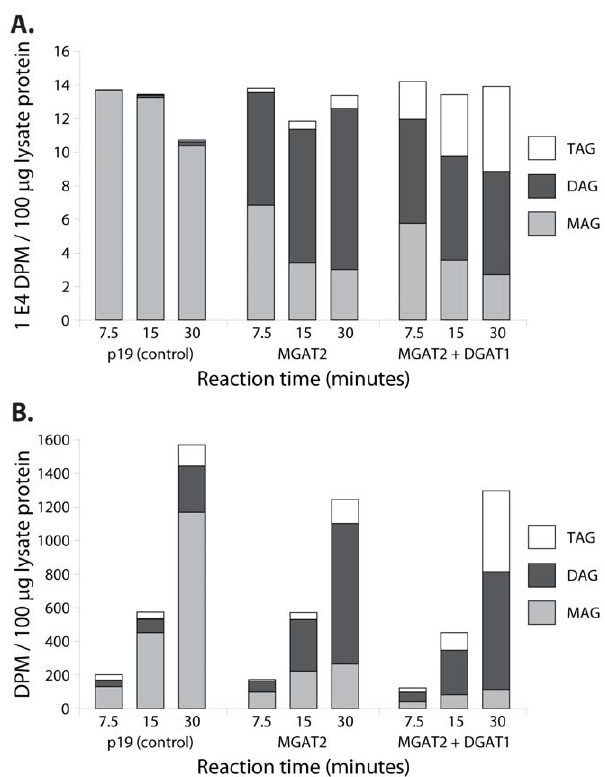
Figure 2. Radioactivity (disintegrations per minute, DPM) of monoacylglycerol (MAG), diacylglycerol (DAG) and triacylgly- cerol (TAG) fractions isolated from transiently-transformed N. benthamiana leaf lysates at three different time points and after feeding with A. [ 14 C] sn2 -MAG and unlabelled oleoyl-CoA or B. [ 14 C] glycerol-3-phosphate and unlabelled oleoyl-CoA. N. benthamiana leaves were infiltrated in triplicate with either the 35S::p19 construct alone (negative control), 35S::p19 and